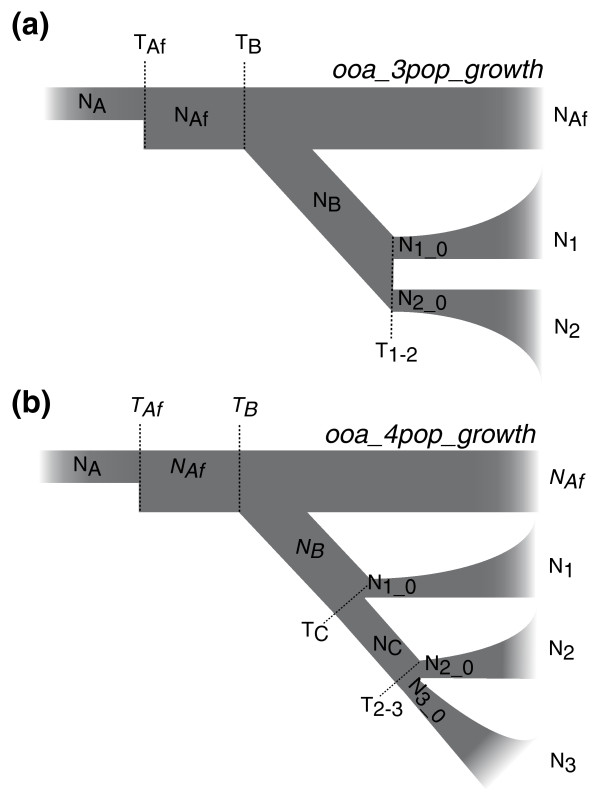
Illustration of the ∂a∂i models. (a) Three-population out-of-Africa model. The ten parameters estimated in the model (NA, NAf, NB, N1_0, N1, N2_0, N2, TAf, TB, T1-2,) are shown. (b) Four-population out-of-Africa model. The ten parameters estimated in the model (NA, NC, N1_0, N1, N2_0, N2, N3_0, N3, TC, T2-3,) are shown. NAf, NB, TAf, and TB are fixed in this model.